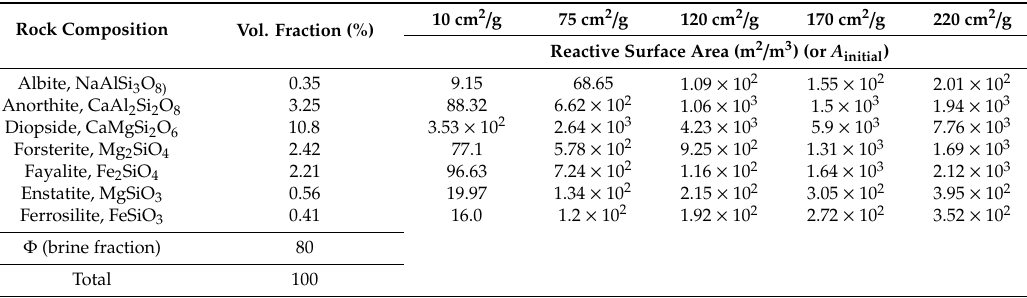
Table 2. Considered modal composition assumed for cumulate gabbro modelling and reactive surface area considered for the calculations.